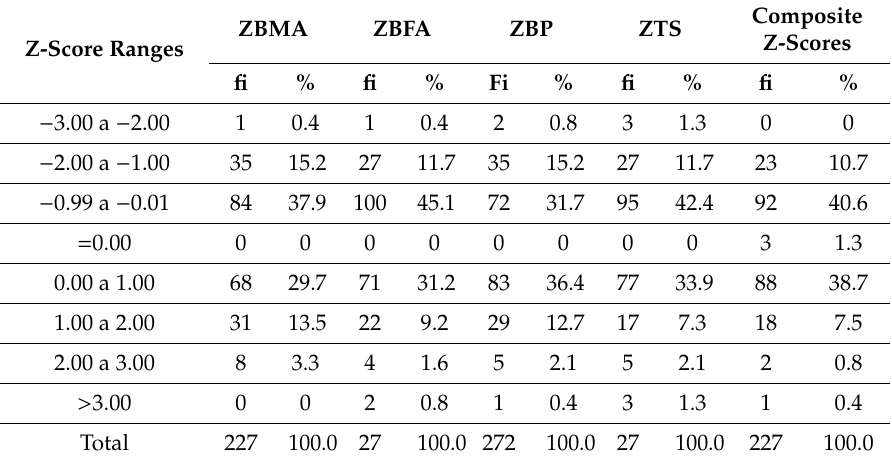
Table 2. Distribution of Z-Scores from Brachial Mass Area (BMA), Brachial Fat Area (BFA), Brachial Perimeter (BP) and Tricipital Skinfold (TS) and Composite